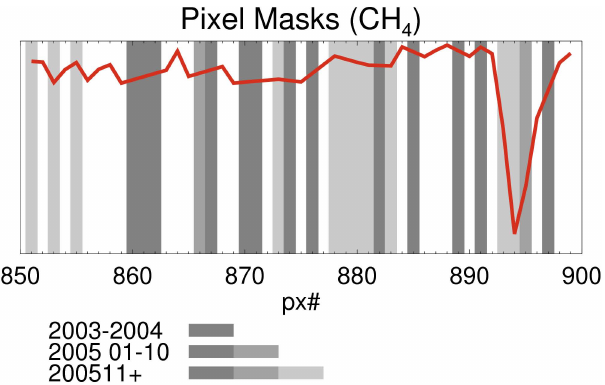
Fig. 1. Pixel masks used for the WFMDv2.0 methane retrieval. The red line shows the CH 4 absorption and the shaded regions indicate bad pixels. Due to proceeding detector degradation in the spectral range used for the methane column retrieval three different time pe- riods are used. Since November 2005 only one remaining detector pixel (#896) in the Q-branch (the spectral region where the strongest absorption occurs) of the 2 ν 3 methane band is